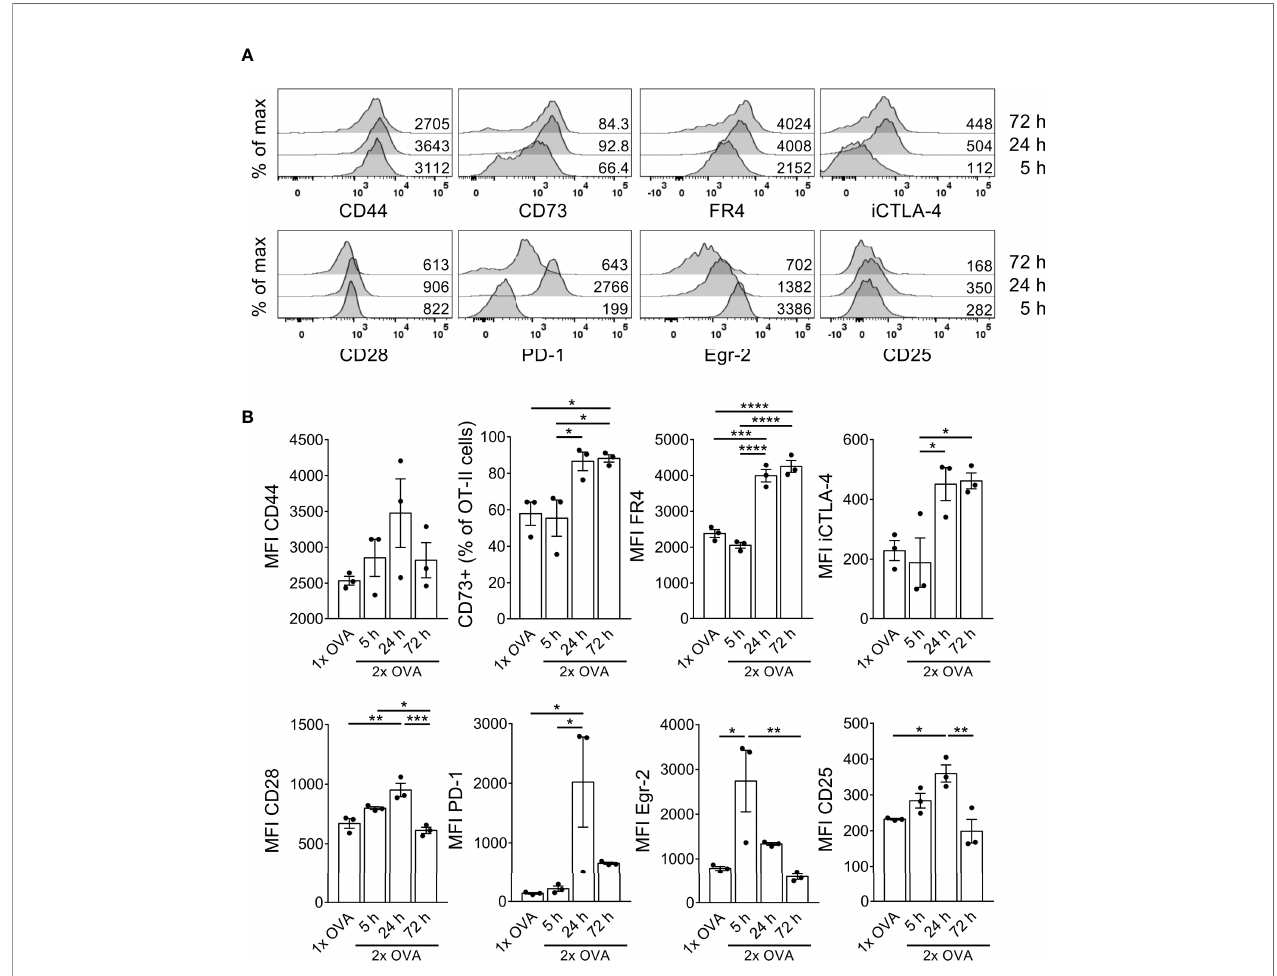
FIGURE 3 | T cells retain their anergic phenotype after a second OVA injection within a short time interval. OT-II.Rag1 -/- cells were adoptively transferred into C57BL/6 WT recipient mice and received a fi rst i.v. OVA protein injection 1 day after adoptive transfer. A second OVA injection was given 3 days after the fi rst one. 5, 24 or 72 hours after the second injection, spleen cells were isolated and stained for indicated surface markers. (A) Representative histograms depict marker expression in OT-II cells 5 hours (bottom), 24 hours (middle) or 72 hours (top) after the second OVA injection. Numbers indicate MFIs or frequency of CD73 + cells within OT-II cells. (B) Data from A summarized as mean ± SEM. Dots represent individual mice. *p < 0.05, **p < 0.01, ***p < 0.001, ****p < 0.0001, one-way ANOVA with Tukey